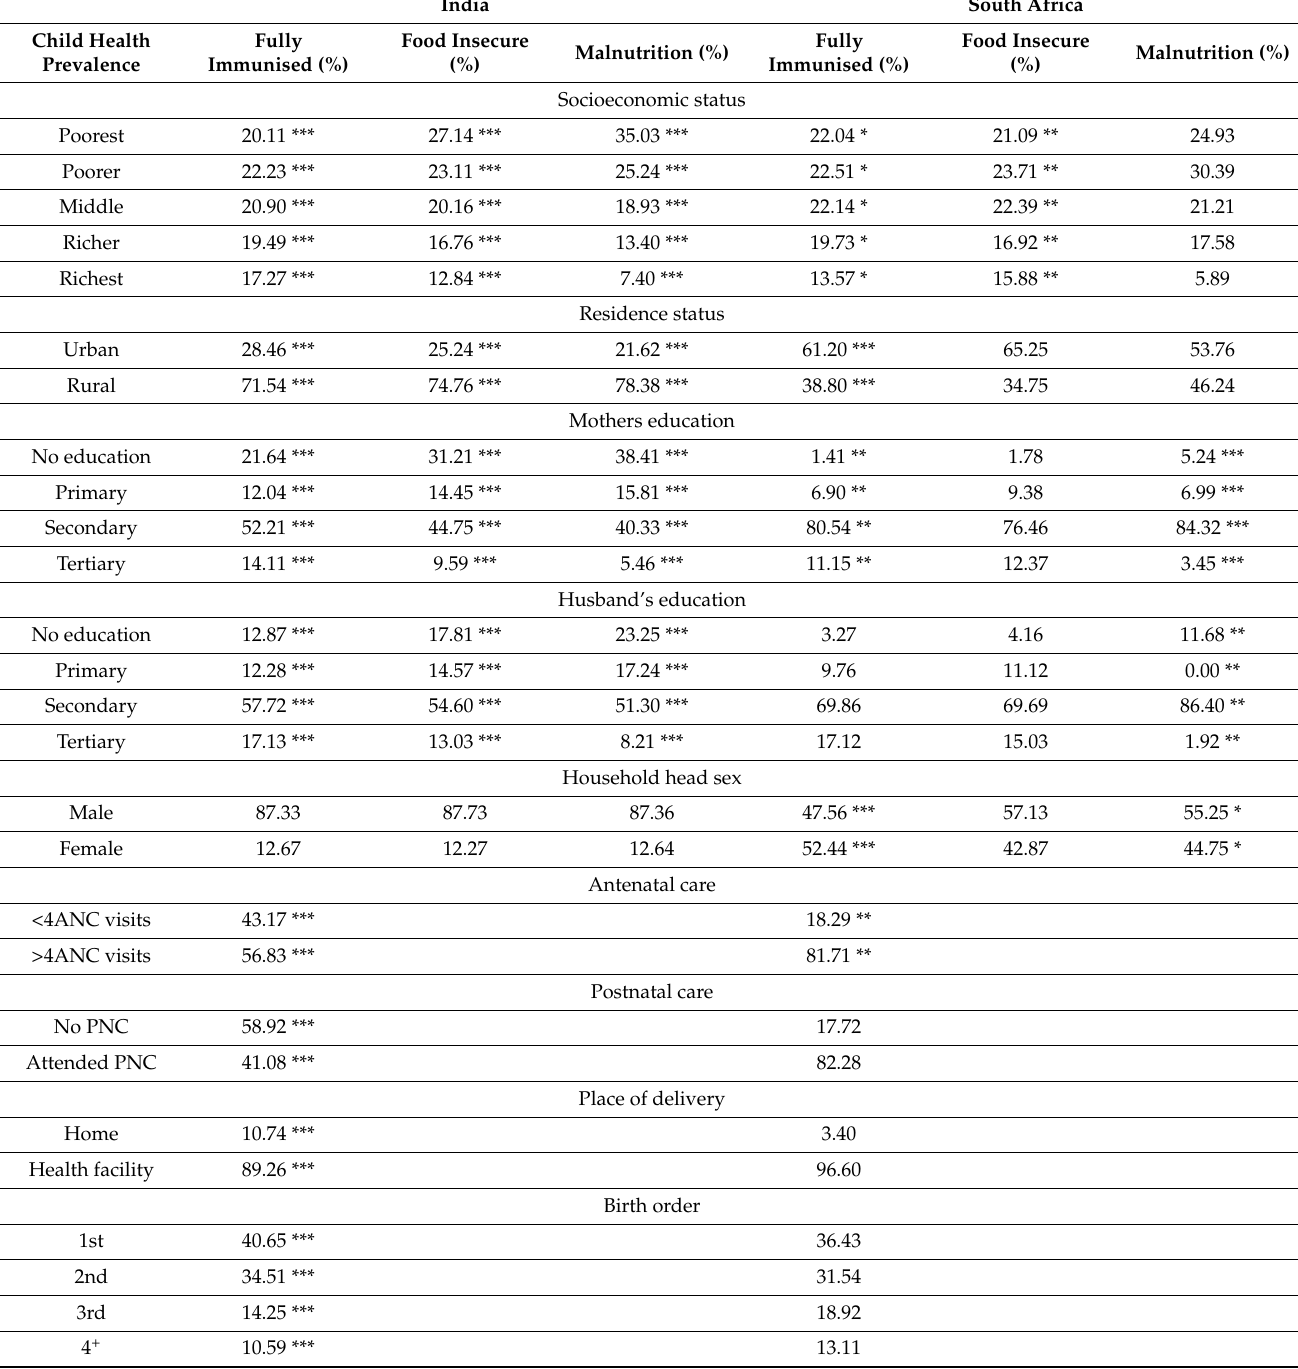
households with more than five members accounted for the biggest proportions of food- insecure and malnourished children (Table 2). Table 2. Immunisation, food insecurity and malnutrition percentage prevalence across child health determinants in India and South Africa for 2015/16. India South